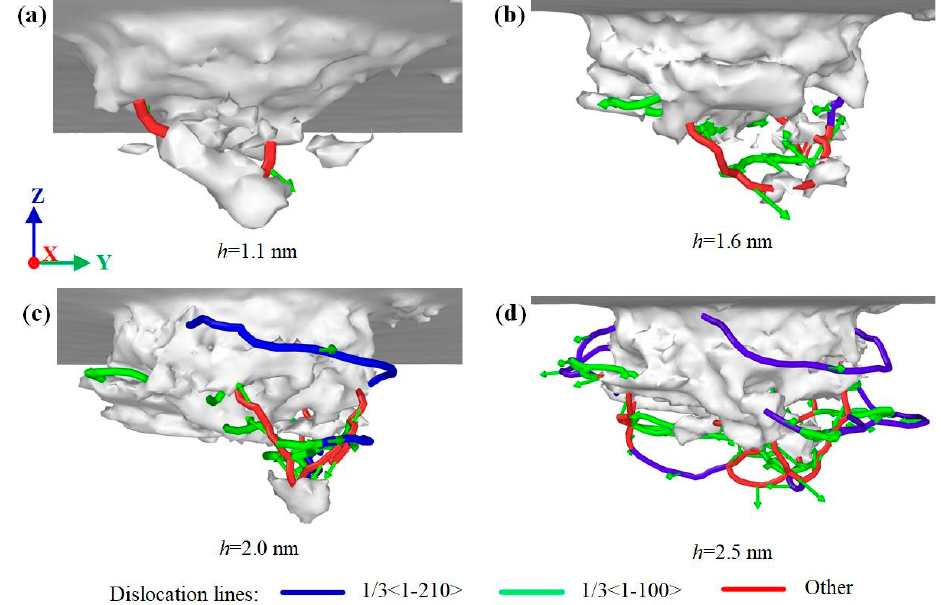
Figure 10. Dislocation distribution of 6H-SiC at different indentation depths: ( a ) h = 1.1 nm, ( b ) h = 1.6 nm, ( c ) h = 2.0 nm, and ( d ) h = 2.5 nm, respectively. The differences in dislocation evolution mainly depend on the arrangement charac- teristics of crystal atoms and the direction of load. For 3C-SiC, because the {111} plane is the strong cleavage plane of 3C-SiC. The atoms along the {111} plane are densely arranged and are most prone to sliding behavior. With the increase of indentation depth, dislocation reactions on (11-1) and (111) planes were observed at h = 2.6 nm, accompanied by a small number of partial dislocations, circled with an elliptical dotted line in Figure 8. The dislo- cation transformation is carried out by dislocation decomposition and dislocation synthe-